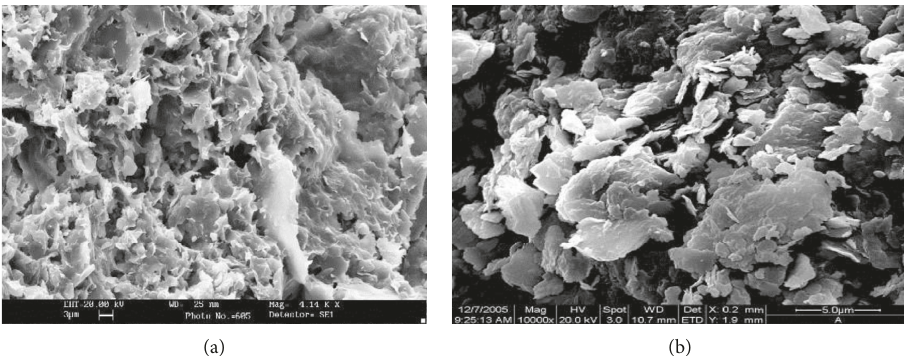
Figure 3: SEM images of red clay samples in Tiyu west road station. (a) × 4140 honeycomb I/S with a small amount of needle-like C. (b) × 10,000 flake-flocculent